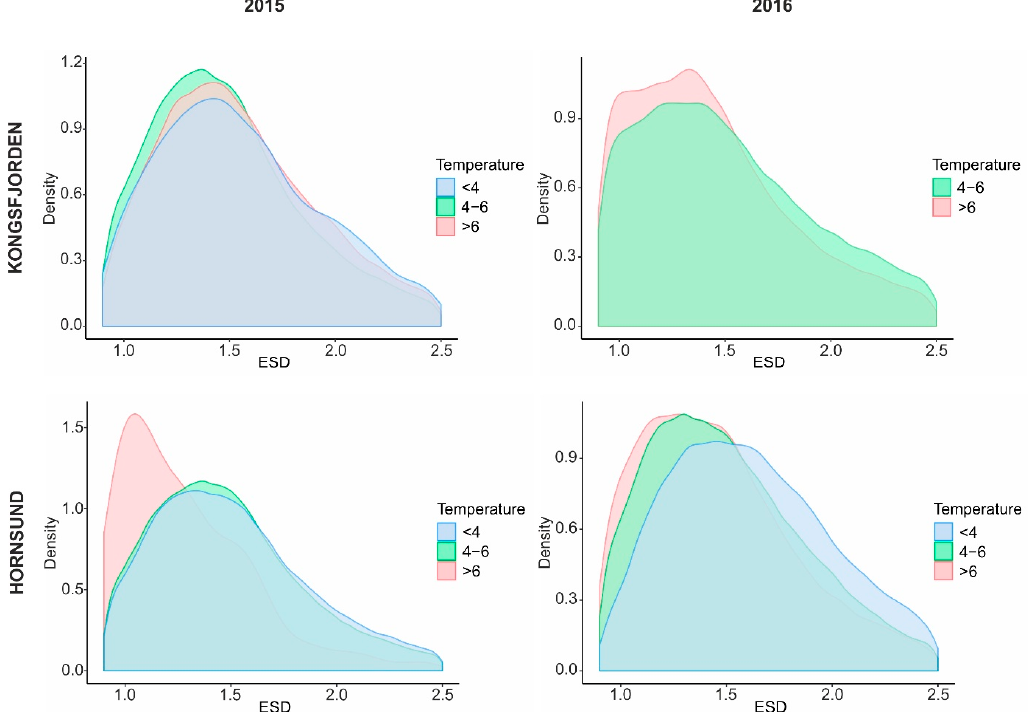
Figure 4. Size distribution of Calanus ‐ type particles expressed as equivalent spherical diameter (ESD, mm) recorded by laser optical plankton counter (LOPC) in different temperature ranges